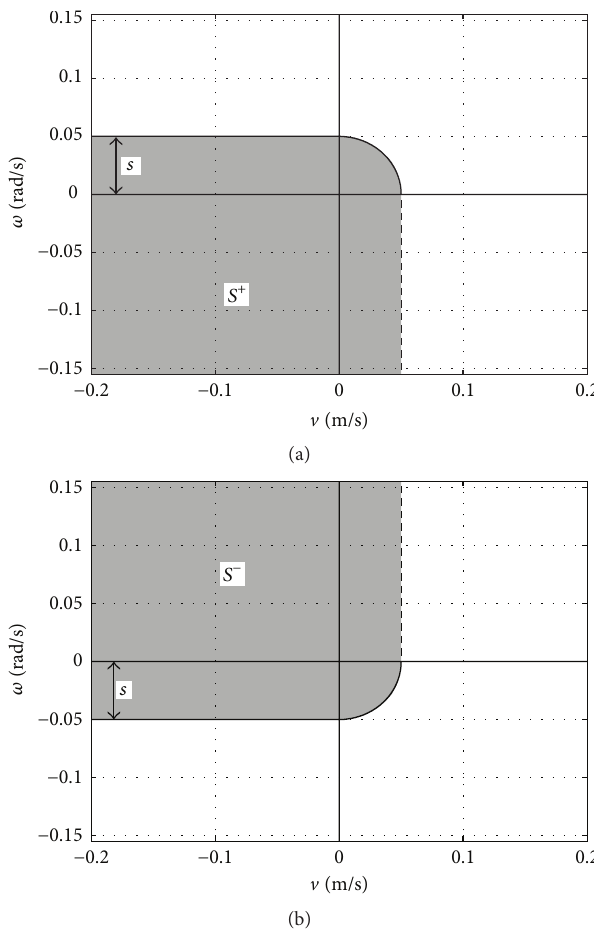
Figure 5: Graphical representation of 𝑆 + (a) and 𝑆 − (b).